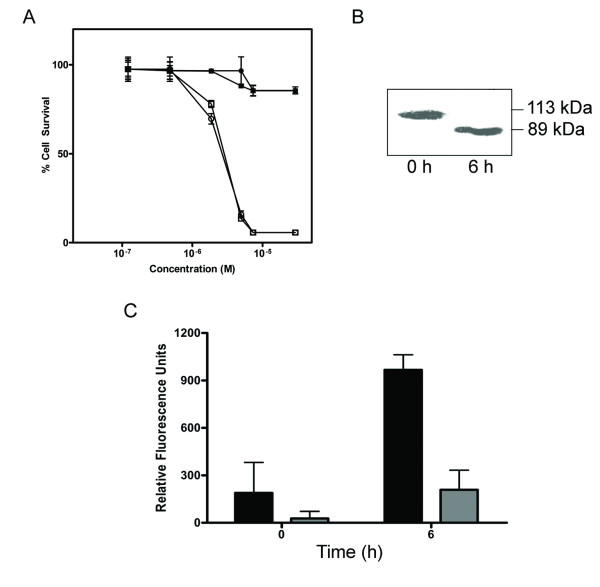
The cellular activities of SLT-1AIYSNKLM are linked to its catalytic activity. (A) Dose-response curves indicating a comparable cytotoxicity for the purified, furin-cleaved A subunit of SLT-1AIYSNKLM (A1 and A2 subunits remain linked by a disulfide bridge between C242 and C261; white squares) and the A1 subunit alone of SLT-1AIYSNKLM (white circles) towards 518-A2 cells. The catalytically-inactive forms (Y77S) of these same molecules (black squares, black circles) were not cytotoxic towards 518-A2 human melanoma cells at concentrations of up to 10 μM. (B) Western blot analysis demonstrating the cleavage of PARP following treatment of 518-A2 cells with SLT-1AIYSNKLM. (C) Effect of exposing 518-A2 (black bars) and PC-3 cells (grey bars) to SLT-1AIYSNKLM on the activation of caspase-3 as measured using a fluorescent peptide substrate for caspase-3. PC-3 cells are insensitive to SLT-1AIYSNKLM. Error bars represent s.e.m. for experiments performed in quadruplicate.